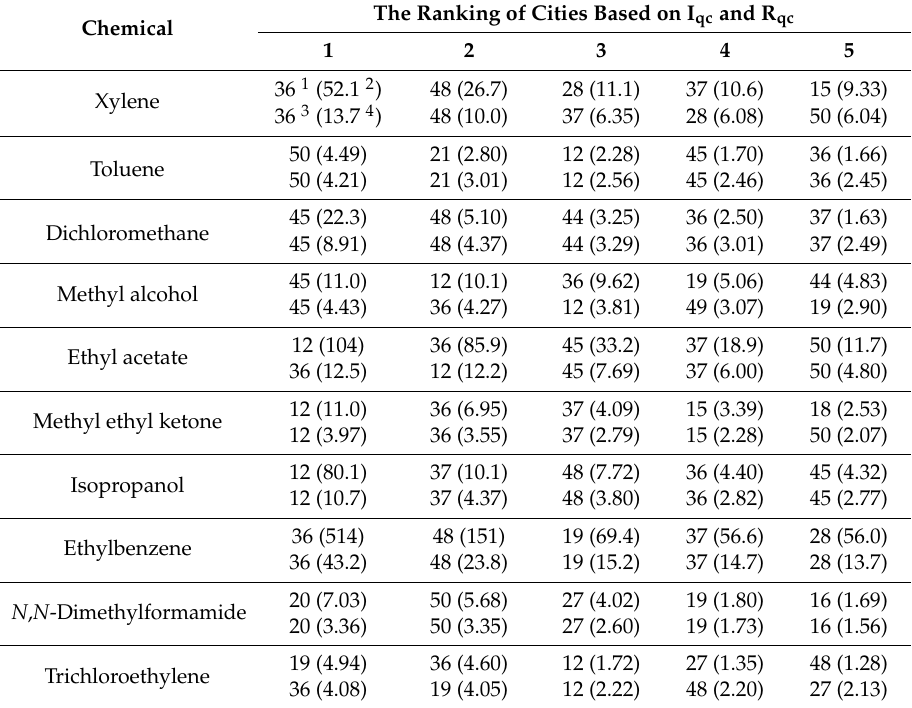
Table 3. Relative transfer (I qc ) and potential risk (R qc ) of each chemical from 2001 to 2012. The Ranking of Cities Based on I qc and R Chemical